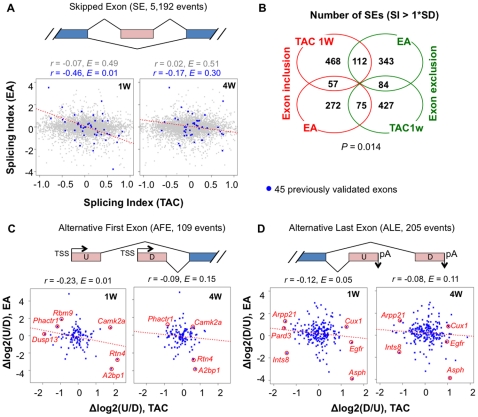
Comparison of mRNA isoform regulation in cardiac hypertrophy and development.(A) Comparison of SI for skipped exons (SE). Skipped exons were defined by cDNAs/ESTs. Grey dots are all expressed SE events, and blue dots are the ones that are developmentally regulated and experimentally validated in a previous study [25]. The dotted red line is based on linear regression of blue dots. Pearson correlation coefficient was calculated for each plot, and its E value was estimated based on random sampling of the same number of exons (see Materials and Methods for detail). (B) Venn diagram showing the highly regulated SEs in hypertrophy and development. Highly regulated SEs were selected using 1*SD of SI. (C) and (D) Regulation of alternative first and last exons. U and D are upstream and downstream terminal exons, respectively. Alternative terminal exons were analyzed using difference in log2(U/D) or log2(D/U), where U/D or D/U are ratios of probe set intensities between U and D.